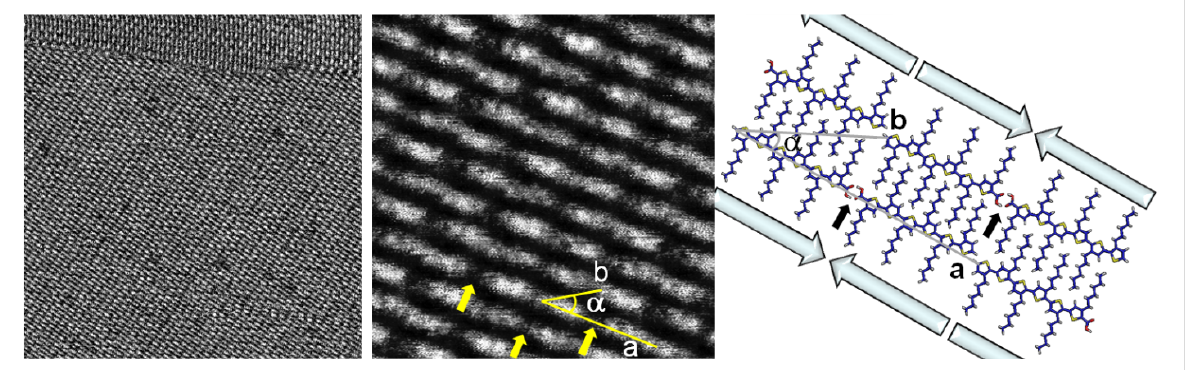
Figure 3: STM image of H6TCOOH . Left: 70 × 70 nm 2 , U = − 360 mV, I = 50 pA. Center: 20 × 20 nm 2 , U = − 361 mV, I = 50 pA. Right: Theoretical model. The small black arrows emphasize the H-bonding position. The big arrows indicate the orientation of the molecular dipole moments.